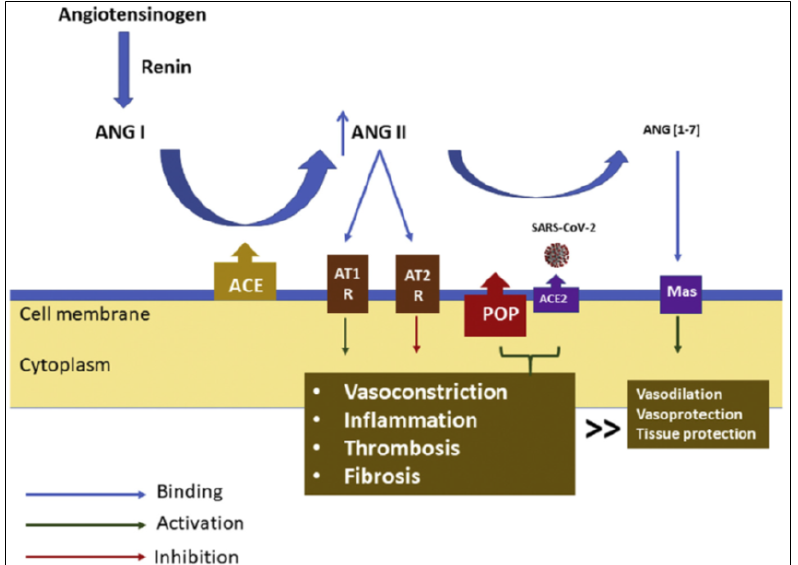
Figure 2. The counter-regulatory renin–angiotensin system (RAS) axis in the lungs in the coronavirus disease 2019 (COVID-19) setting. Angiotensin-converting enzyme 2 (ACE2) serves as the severe acute respiratory syndrome coronavirus (SARS-CoV)-2 receptor, whereas the proinflammatory prolyloligopeptidase (POP) converts less effectively than ACE2 the deleterious angiotensin (ANG) II to the protective ANG (1–7). As a result, deleterious signalling (inflammation, thrombosis and fibrosis) dominates over protective (vasodilation, vasoprotection and tissue protection) signalling in patients with severe COVID-19, which may lead to acute lung injury. Abbreviations: AT1R, angiotensin receptor type 1; AT2R, angiotensin receptor type 2 [45].